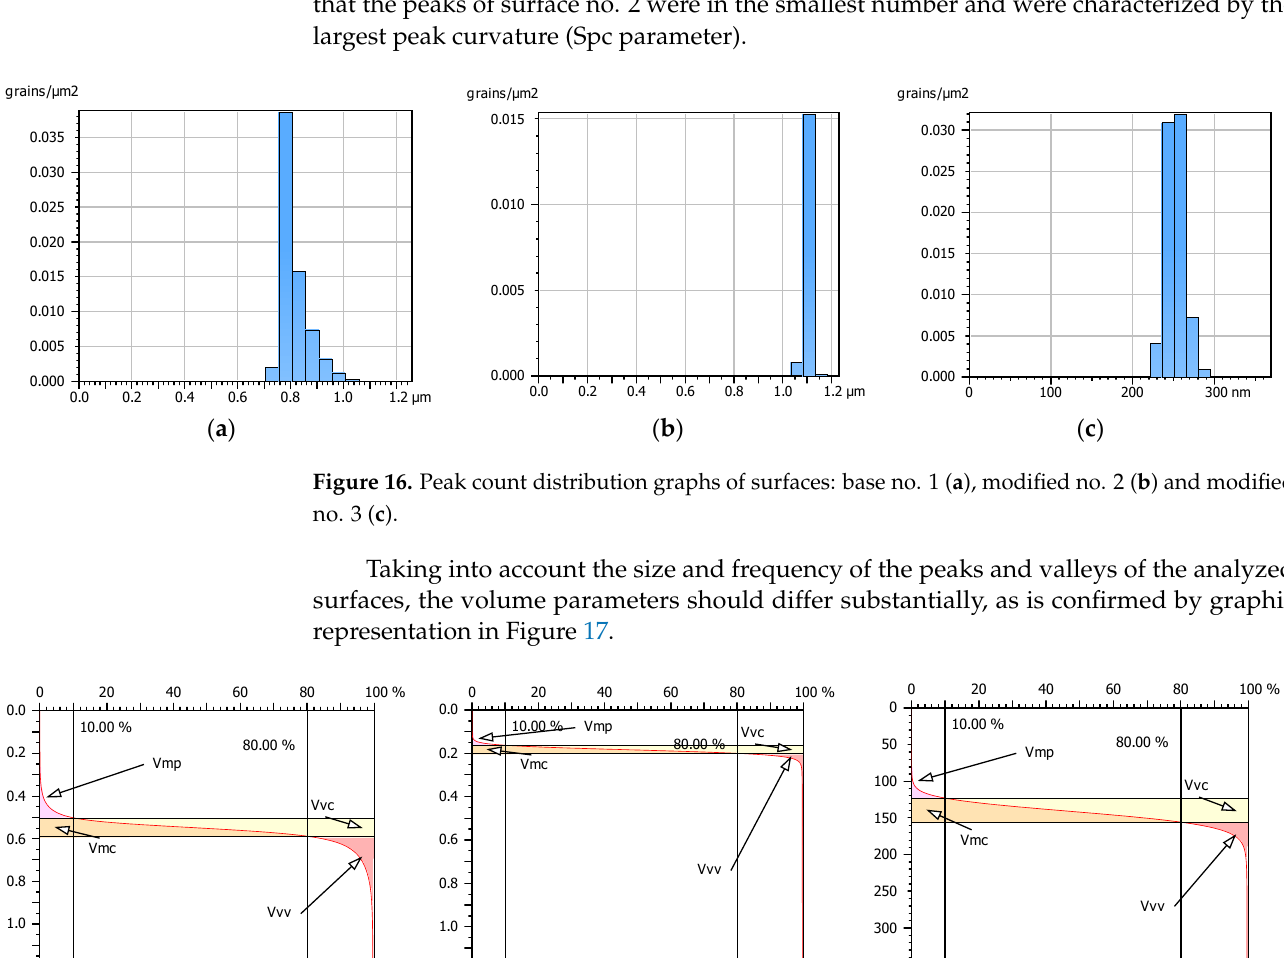
Analyzing peak-count histograms, the limited number of peaks size is observed for surface no. 2 and the density of peaks is the smallest for this modified surface (Figure 16) which is also in good correlation with the values of the Spd parameter. It is also important that the peaks of surface no. 2 were in the smallest number and were characterized by the largest peak curvature (Spc parameter).